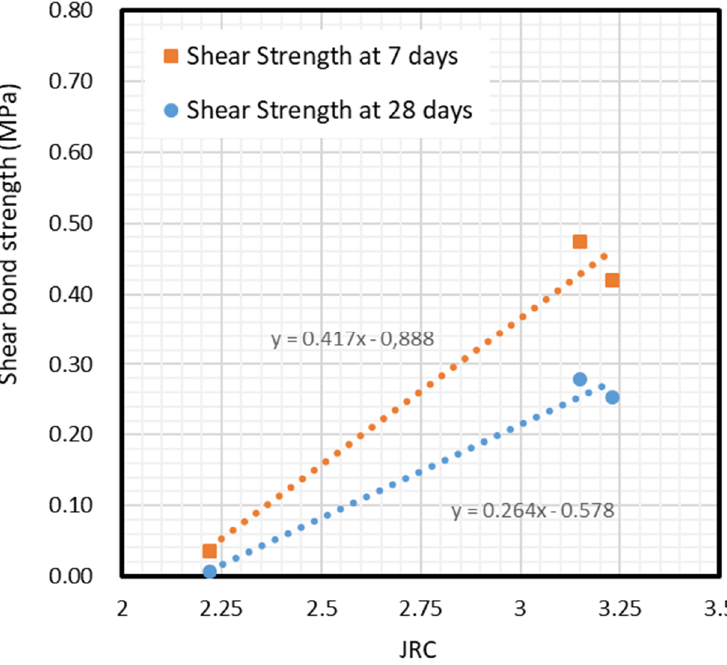
ff erent bond strengths and